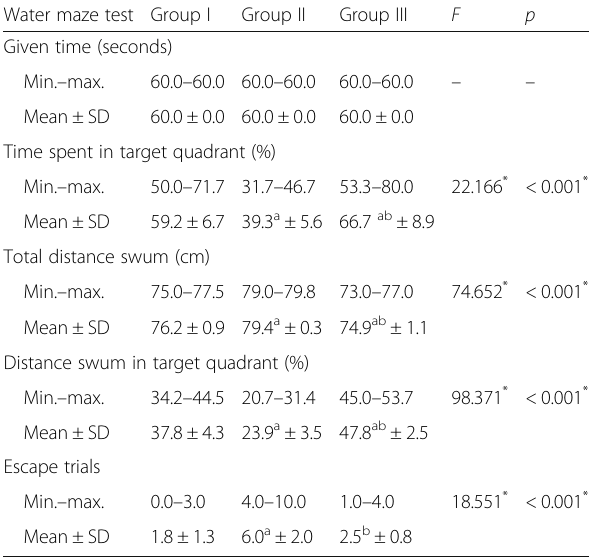
Table 3 Comparison between the three studied groups according to given time, time spent in target quadrant, total distance swum, distance in target quadrant, and escape trials (water maze test)